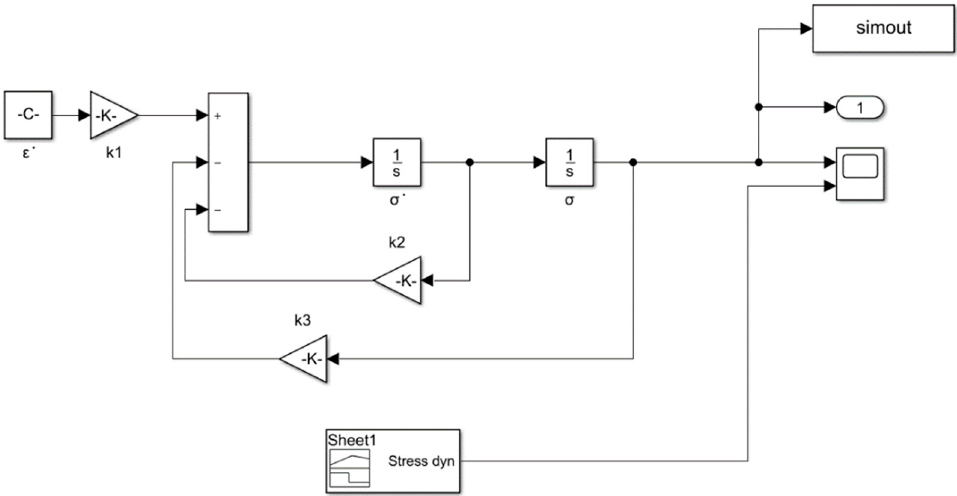
Figure 9. Simulink simulation.